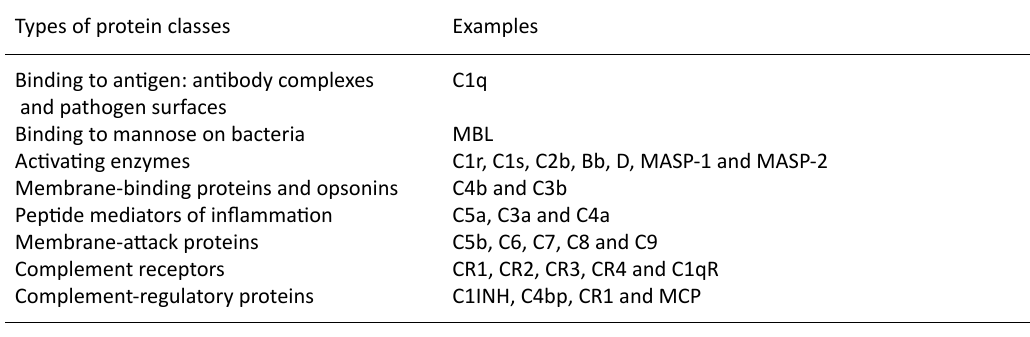
table 3. Functional protein classes in the complement system Types of protein